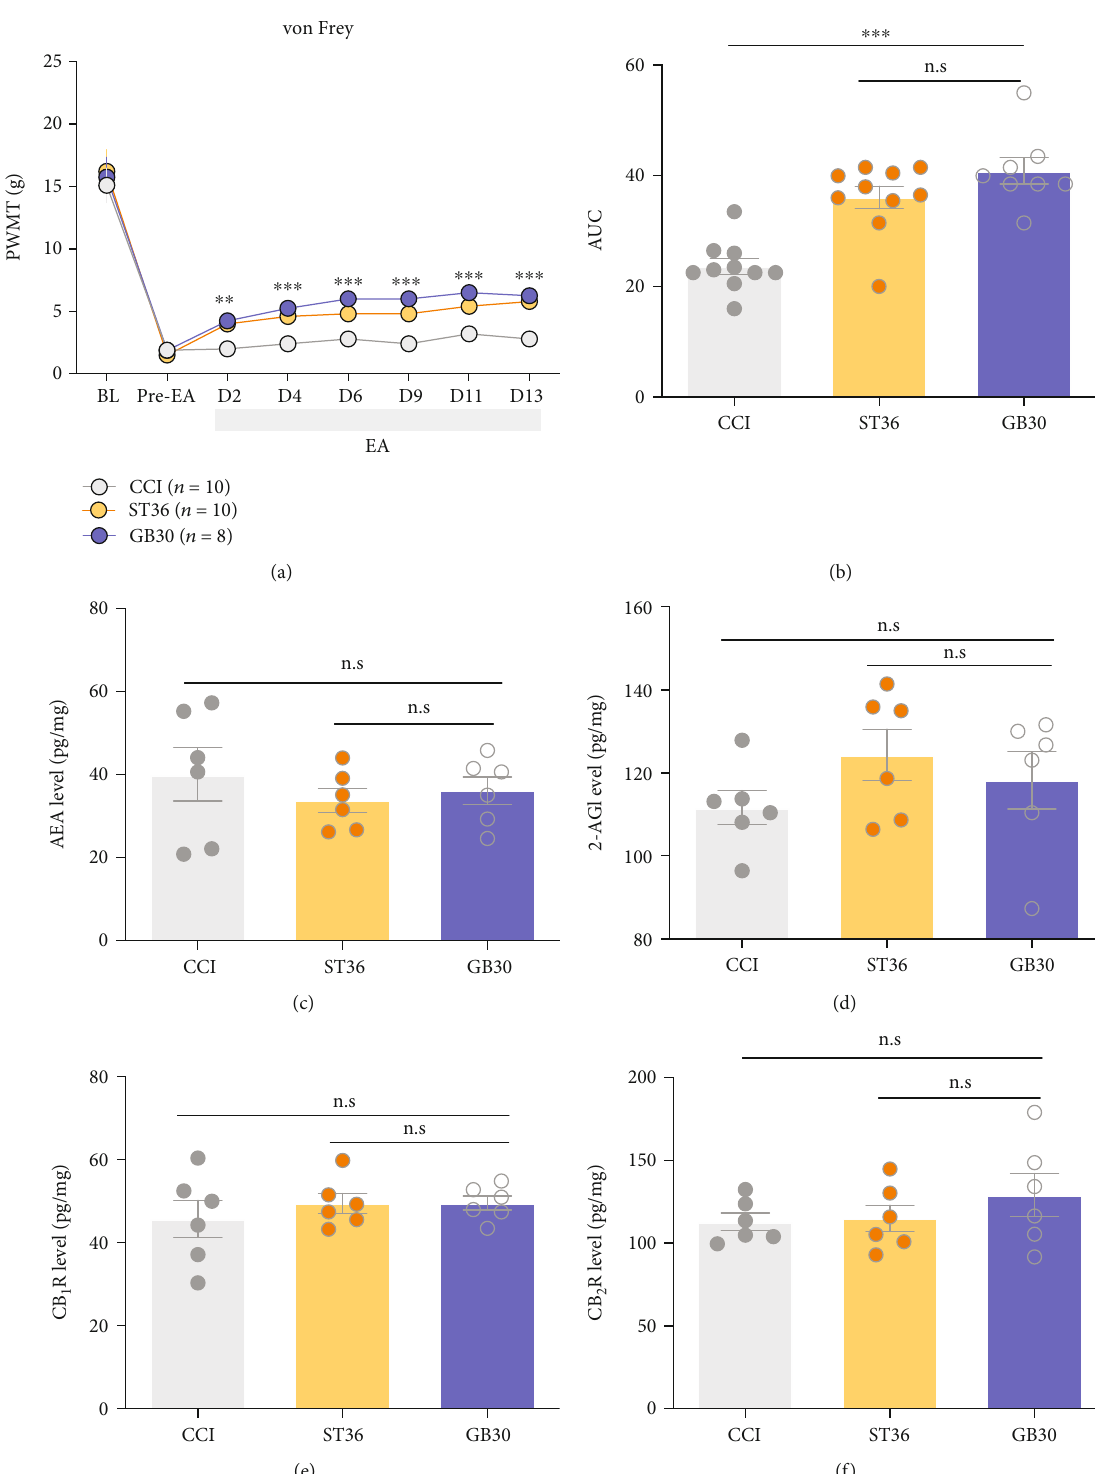
Figure 7: EA stimulation at single-acupoint GB30 was unable to provide a superior analgesic e ff ect than ST36 in the ECS independent manner. (a) EA stimulation at GB30 provided a comparable analgesic e ff ect to EA stimulation at ST36; two-way ANOVA followed by Bonferroni ’ s multiple comparisons test. (b) Area under the curve of graph a (from “ BL ” to D13). Student ’ s unpaired t -test. EA stimulation at GB30 did not elevate the AEA (c), 2-AG (d), CB are mean ± SEM , ∗∗ P < 0 : 01 , ∗∗∗ P < 0 : 001 vs. CCI; n.s.: not signi fi cant; N = 6 in each group. CCI: chronic constriction injury; EA: electroacupuncture; eCB: endocannabinoid; AEA: anandamide; 2-AG: 2-arachidonoyl glycerol; CB cannabinoid receptor 2; ST36: Zusanli acupoint; GB30: Huantiao